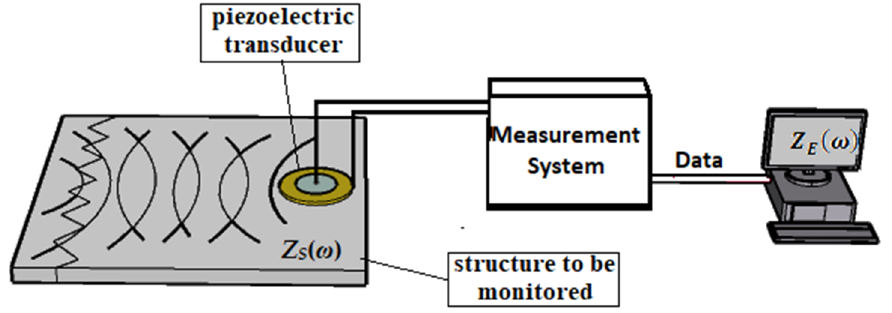
Figure 1. Application of the EMI method.